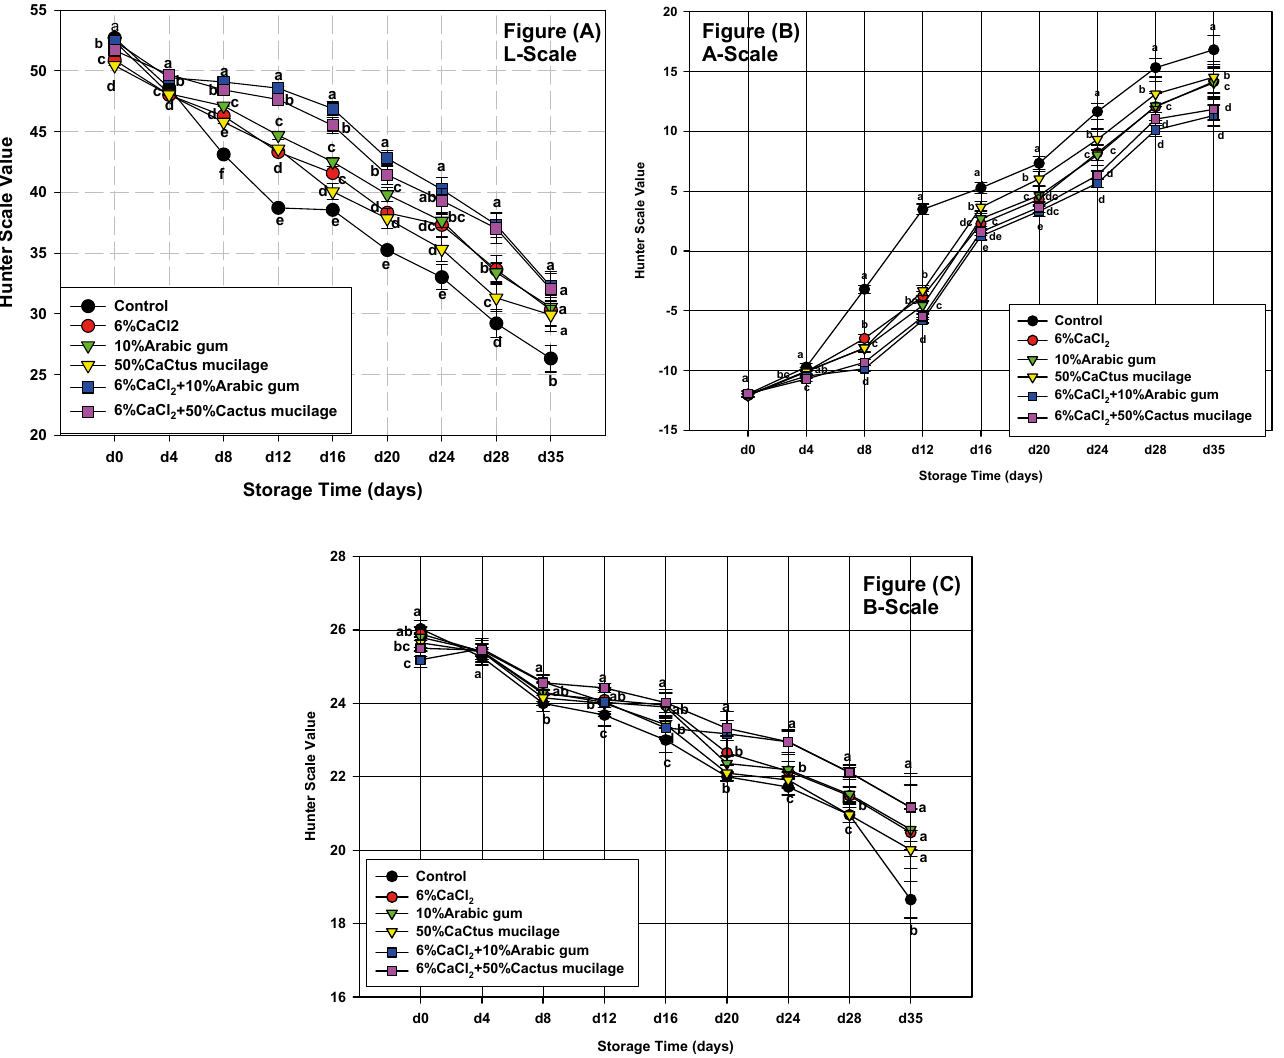
Fig. 3 (A, B, C): Effect of natural substance combination with CaCl 2 on the color development of tomatoes fruit stored at cold storage (10 °C). Means followed by the same letter are not significantly different (Duncan’s multiple range test, P > 0.05)